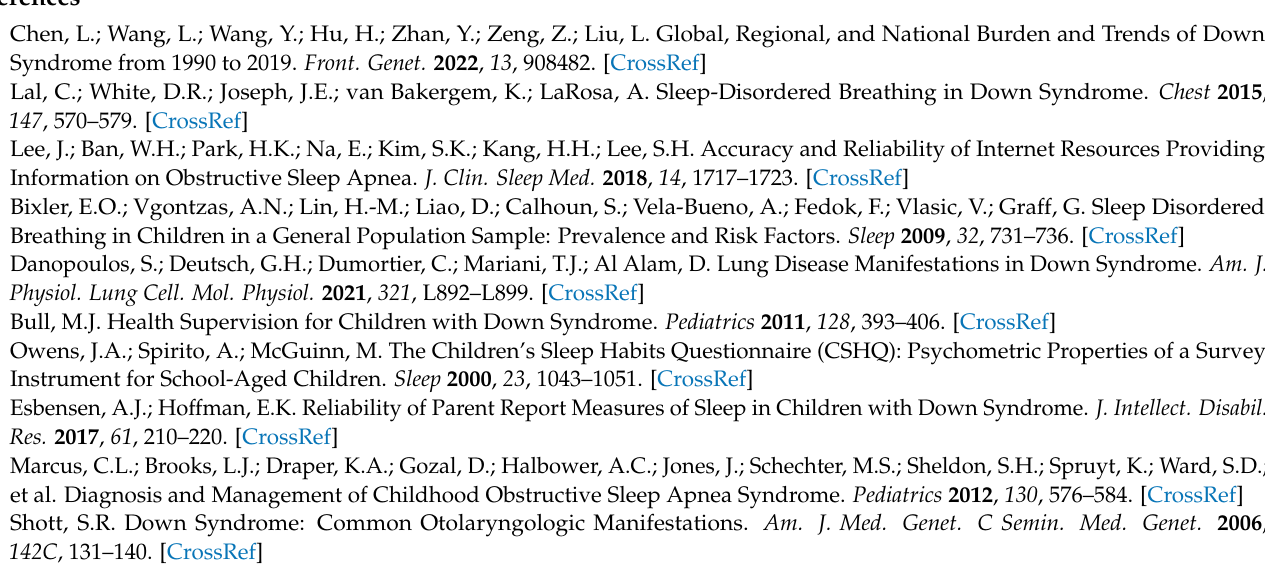
Table S4: Orthodontic evaluation in children with Down syndrome with mild or moderate–severe OSA or without